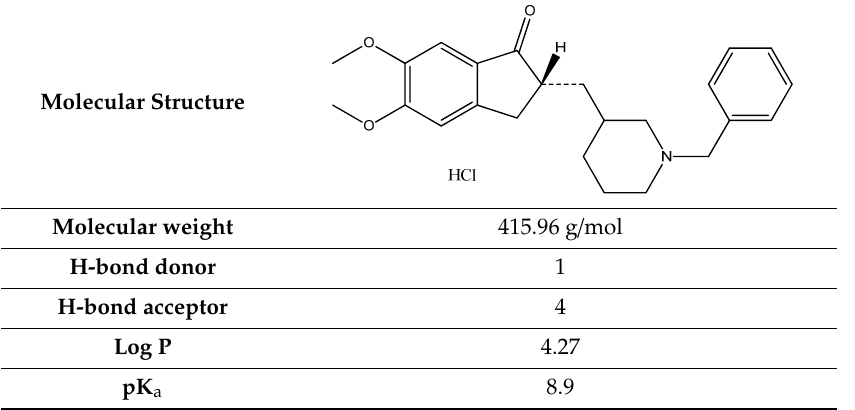
Molecular Structure